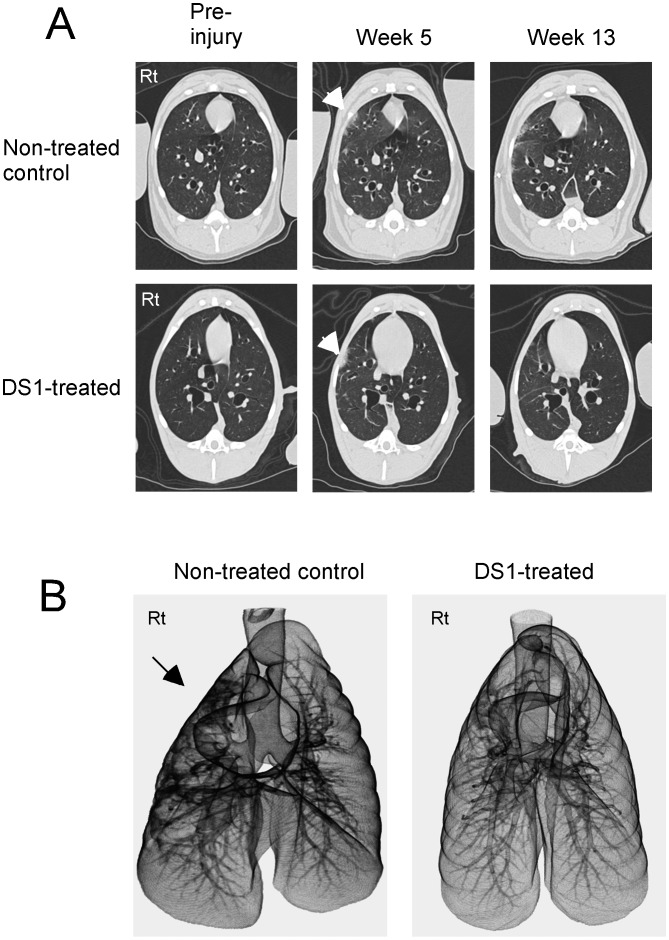
High resolution CT scans of the chest at baseline and then at the indicated time points after 15 Gy right lung irradiation and DS1 cell infusion.Panel A: At baseline, no abnormalities were detected in the lung parenchyma of either dog (Pre-injury). Five weeks after irradiation focal infiltrates were detected in the right lung of both dogs (indicated by the white arrow heads). The non-treated control dog had extensive diffuse interstitial changes in the irradiated right lung and loss of right lung volume at Week 13 (the top right image of panel A). In contrast, nearly complete resolution of the right lung infiltrates was seen in the DS1-treated dog at Week 13 (the bottom right image of panel A). Panel B: CT scans of the whole lung from the DS1-treated and control dog at week 13 were reconstructed in 3D-images. An arrow indicates the right lung of the control dog with extensive damage. These data indicate reversal of radiation-induced lung injury after DS1 administration.